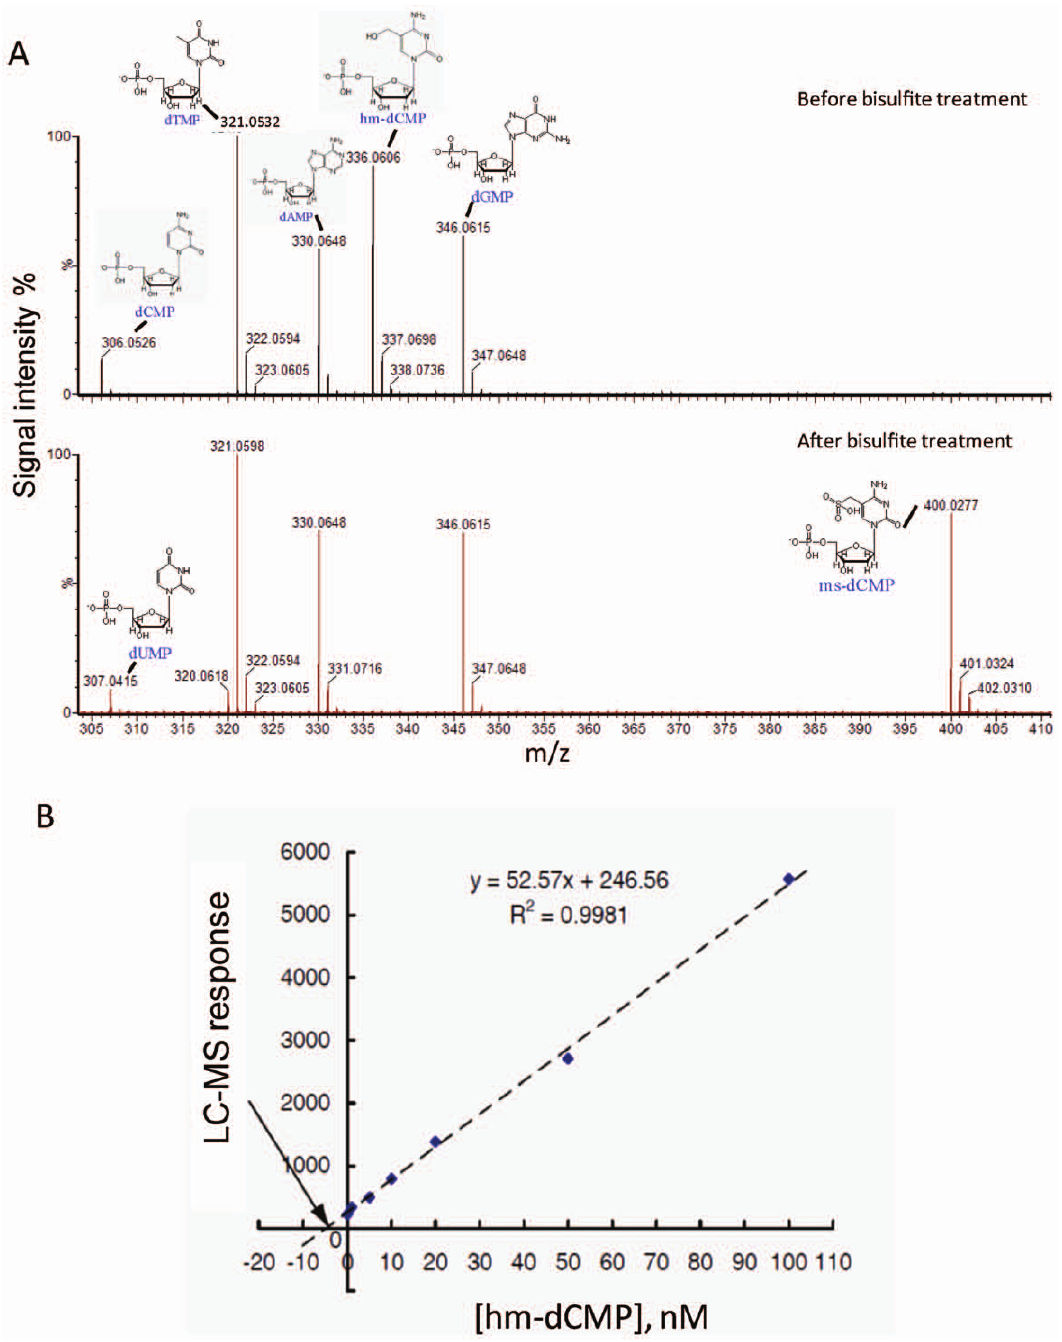
Figure 3. LC-MS analysis of conversion efficiency of 5-hmC to CMS. (A) MS analysis of the nuclease P1 digestion products of the oligonucleotides used in Figure 2A , before (upper panel) and after (lower panel) bisulfite treatment. (B) To determine the conversion efficiency of 5- hmC to CMS in the oligonucleotide shown in Figure 2A , a standard curve was used to determine the unknown quantity of hmdCMP in the sample before and after treatment with sodium bisulfite (see text for details). The absolute value of the intercept of the best-fit line with the X-axis gives the concentration of hmdCMP remaining in the sample after bisulfite treatment as 4.69 nM. Given that the hmdCMP concentration before bisulfite treatment was 1.5 m M, this corresponds to a conversion efficiency as high as 99.7%. and after bisulfite treatment ( Figure 3A , upper and lower panels respectively), was digested with nuclease P1 and subjected to LC- MS analysis. Observed m/z values and corresponding dNMP structure are indicated (mass accuracy is within 0.002 Da). After bisulfite treatment, hm-dCMP ( Figure 3A , upper panel, peak at